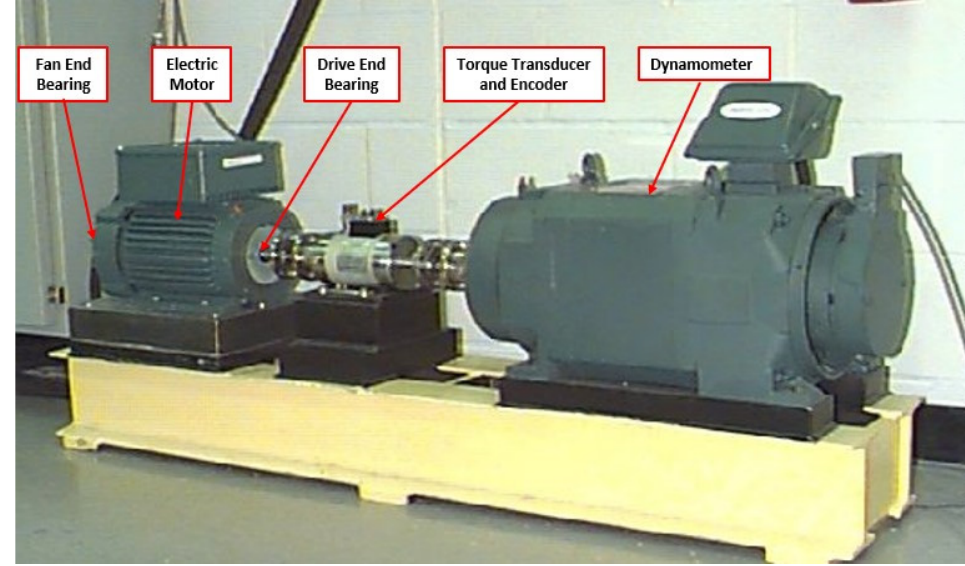
Figure 3. Experimental Setup [38]. Table 1. Different operating conditions.